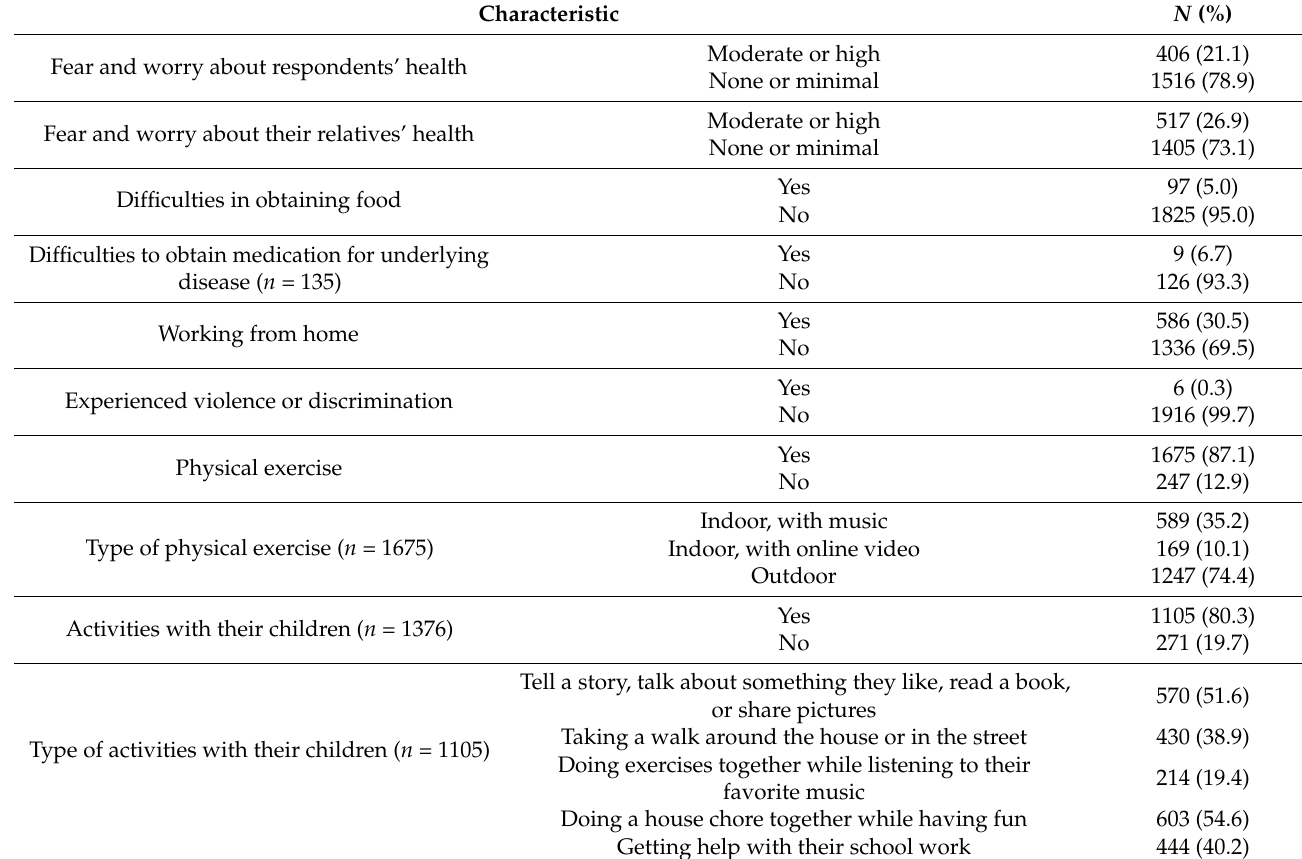
Table 4. Consequences of the COVID-19 pandemic on people’s lives ( n =